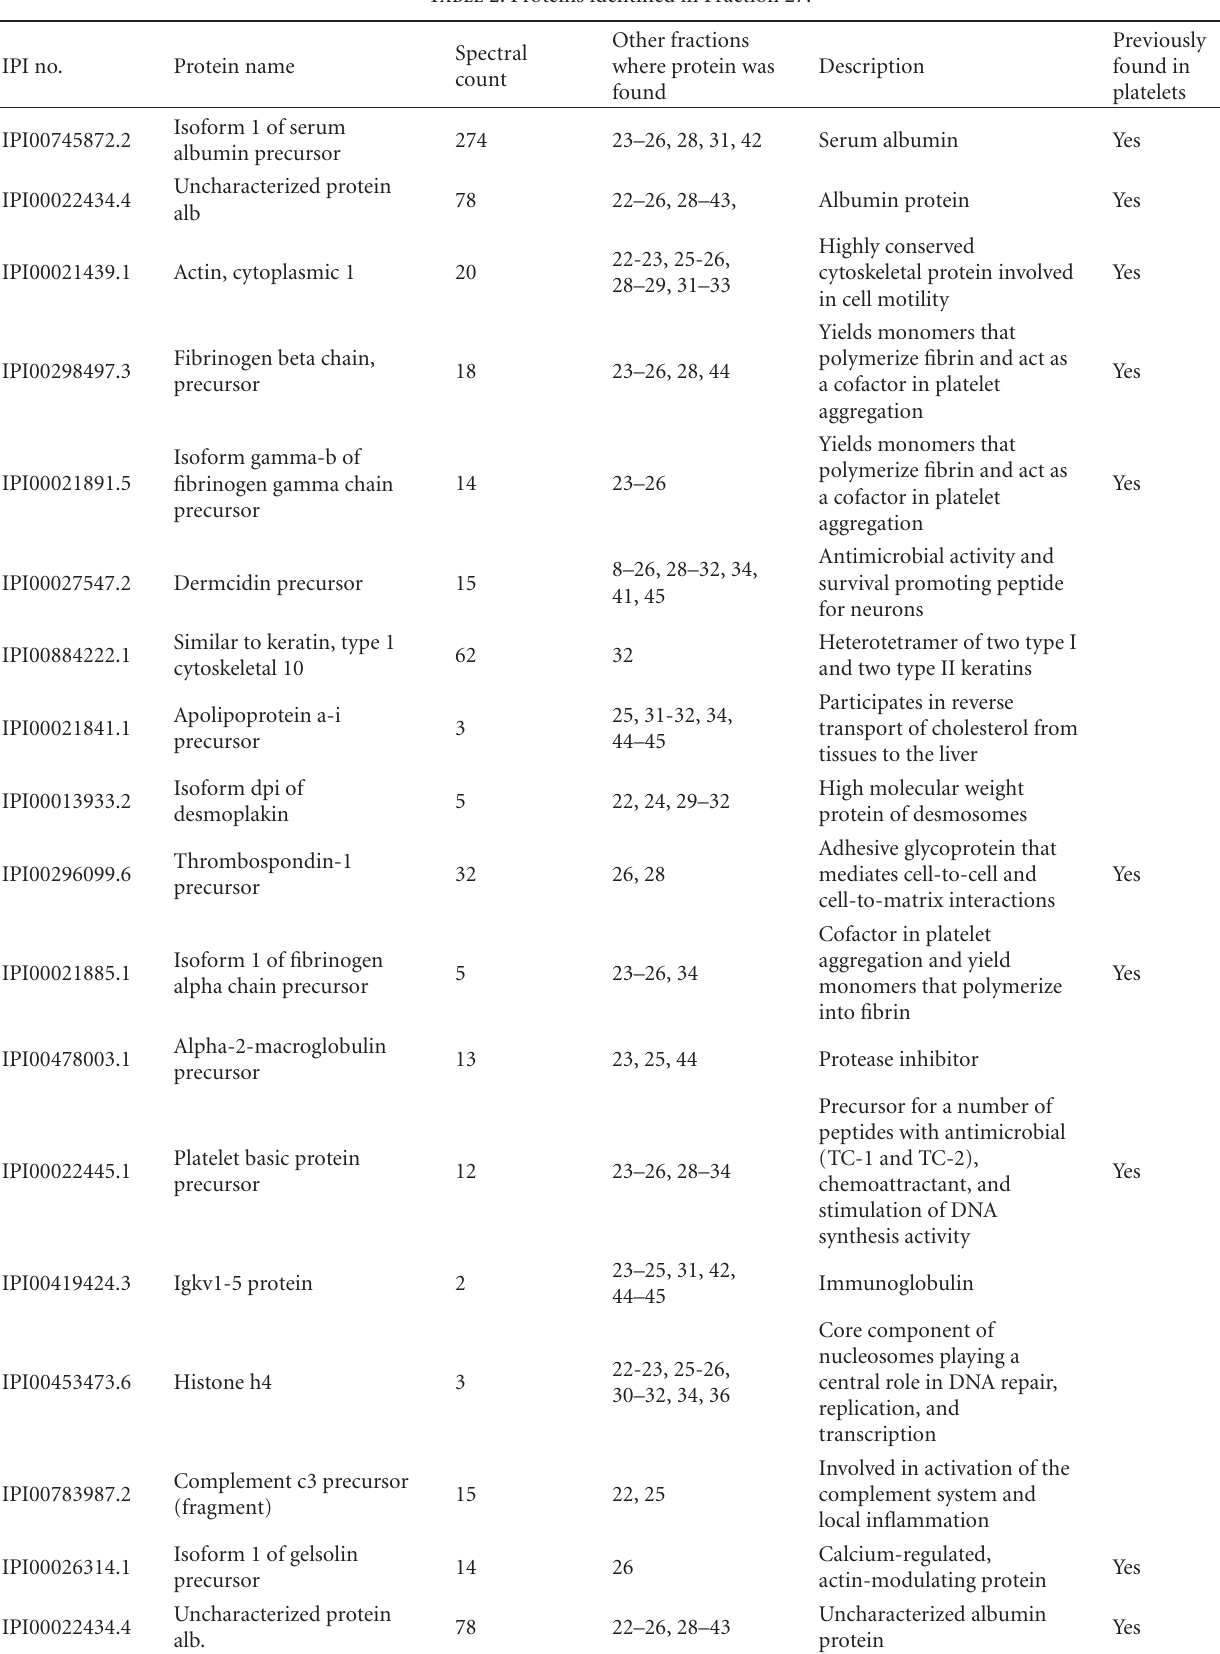
Table 2: Proteins identified in Fraction